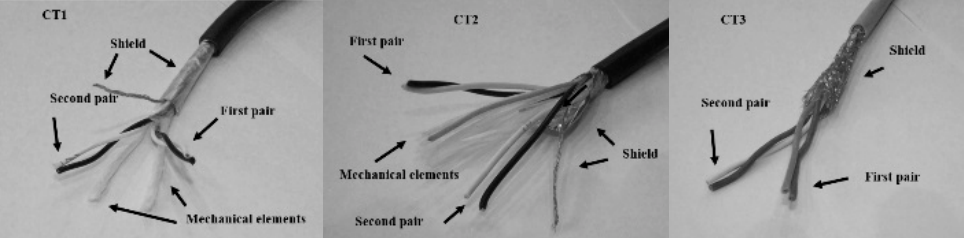
Figure 3. Photo of CT1, CT2, and CT3.